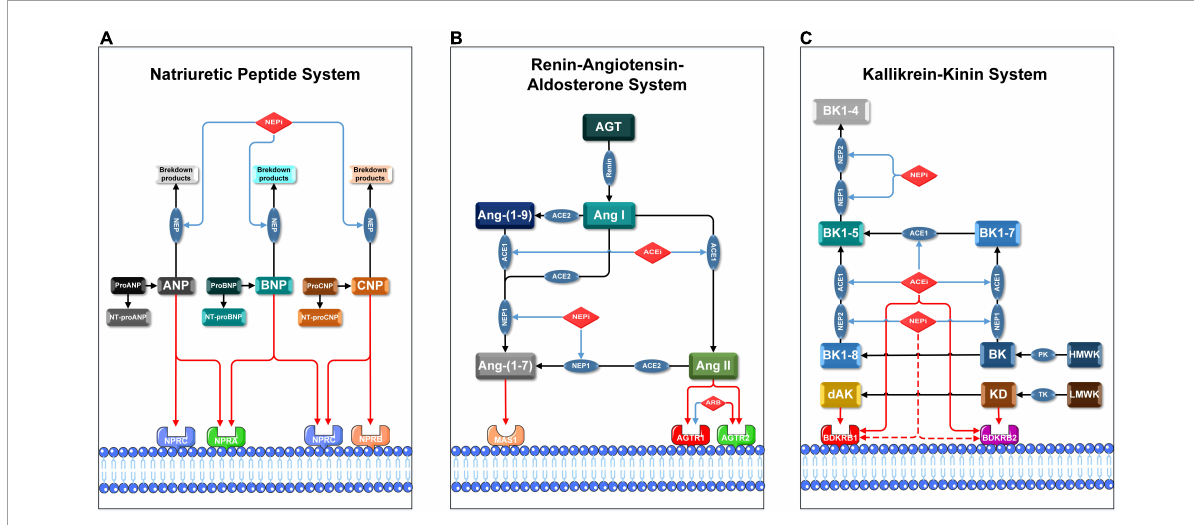
FIGURE1 Pharmacological mechanisms of ARNis and ACEis in NPS, RAAS, and KKS. Blue lines indicate inhibitory or blocking effects, red lines indicate activating or stimulating effects, and red dashed lines indicate the hypothetical activating effects of NEPis on bradykinin receptors. AGT: angiotensinogen, Ang-(1-7): angiotensin-(1-7), Ang-(1-9): angiotensin-(1-9), BK1-4: bradykinin-(1-4), BK1-5: bradykinin-(1-5), BK1-7: bradykinin-(1-7), BK1-8: bradykinin-(1-8), dAK: des-Arg10-kallidin, HMWK: high-molecular-weight kininogen, LMWK: low-molecular-weight kininogen, NT-proANP: N-Terminal proANP, NT-proBNP: N-Terminal proBNP, NT-proCNP: N-Terminal proCNP, PK: plasma kallikrein, TK: tissue kallikrein. (A) Membrane receptors in NPS are NPRA, NPRB, and NPRC; key enzymes in NPS are NEP1 and NEP2. Precursor molecules of pro-ANP, pro-BNP, and pro-CNP break up into active ligands (ANP, BNP, and CNP) and corresponding inactive amino-terminal fragments (NT-proANP, NT-proBNP, and NT-proCNP), respectively. (B) Membrane receptors in RAAS are AGTR1, AGTR2, MAS1 proto-oncogene (MAS1); key enzymes in RAAS are ACE1 and ACE2. ACE1 converts Ang I to Ang II and subsequently activates AGTR1 and AGTR2. Either NEP1 or ACE2 converts Ang I or Ang II to Ang-(1-7), which then activates MAS1. (C) Membrane receptors in KKS are BDKRB1 and BDKRB2, both ACE1 and NEPs are involved in degradation of BK and KD in multiple steps. BK is cleaved by PK from HMWK, while KD is cleaved by TK from LMWK. BK and KD are the ligands of BDKRB2. BK and KD can be converted to BK1-8 and dAK, respectively. BK1-8 and dAK are the ligands of